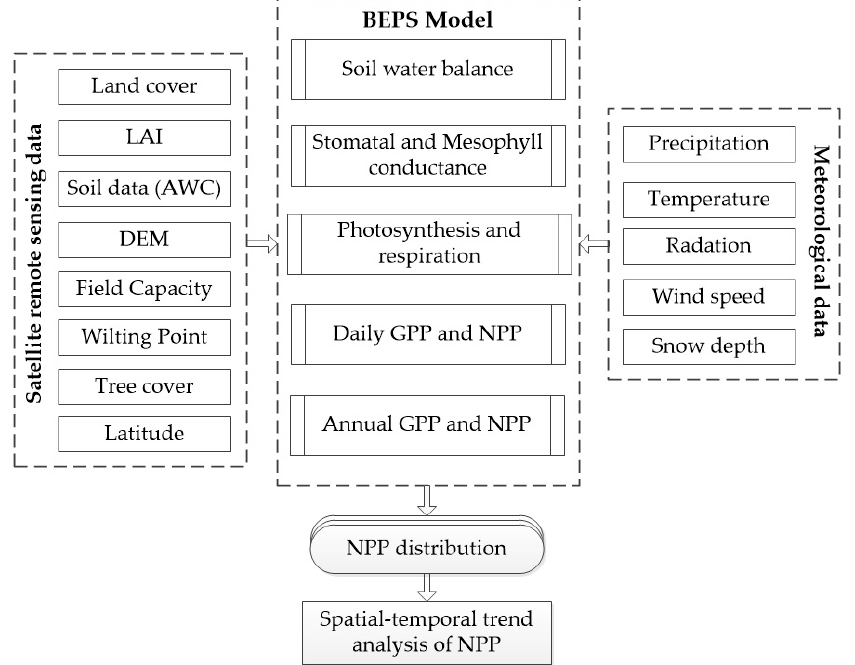
Figure 2. The framework of the Boreal Ecosystem Productivity Simulator (BEPS) model. LAI—leaf area index; AWC—available soil water ‐ holding capacity; DEM—digital elevation model; GPP— area index; AWC—available soil water-holding capacity; DEM—digital elevation model; GPP—gross gross primary productivity; NPP—net primary productivity. primary productivity; NPP—net primary